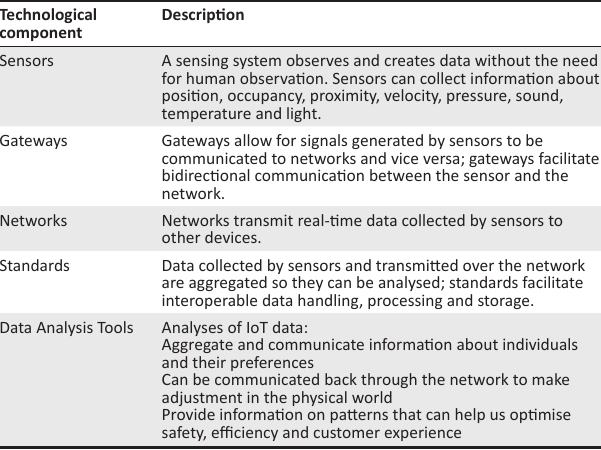
TABLE 1: Internet of things technological components. Technological component